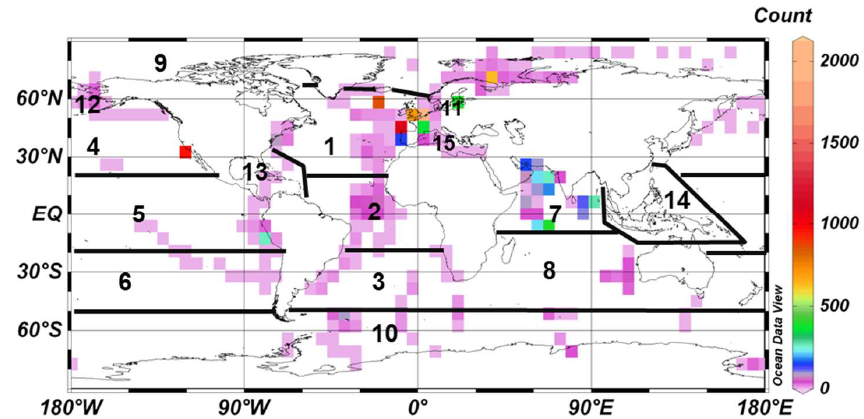
Figure 2. Data distribution according to main oceanic regions (1) North Atlantic, (2) equatorial Atlantic, (3) South Atlantic, (4) North Pacific, (5) equatorial Pacific, (6) South Pacific, (7) north Indian, (8) south Indian, (9) Arctic, (10) Antarctic, (11) Baltic Sea, (12) Bering Sea, (13) Gulf of Mexico and Caribbean Sea, (14) Indonesia, and (15) Mediterranean